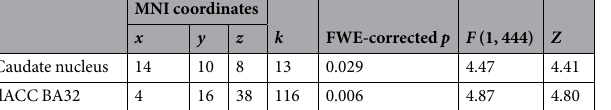
Table 1. Positive interaction: Equality/Selfless > Non-Equality/Selfish. FWE-corrected p < 0.05 for multiple comparisons across the whole brain. The number of k on the FWE-corrected p < 0.05 t -map. Selfless = High (Intermediate/Equality): Low (Equality/Intermediate). Selfish = High (Inequality): Low